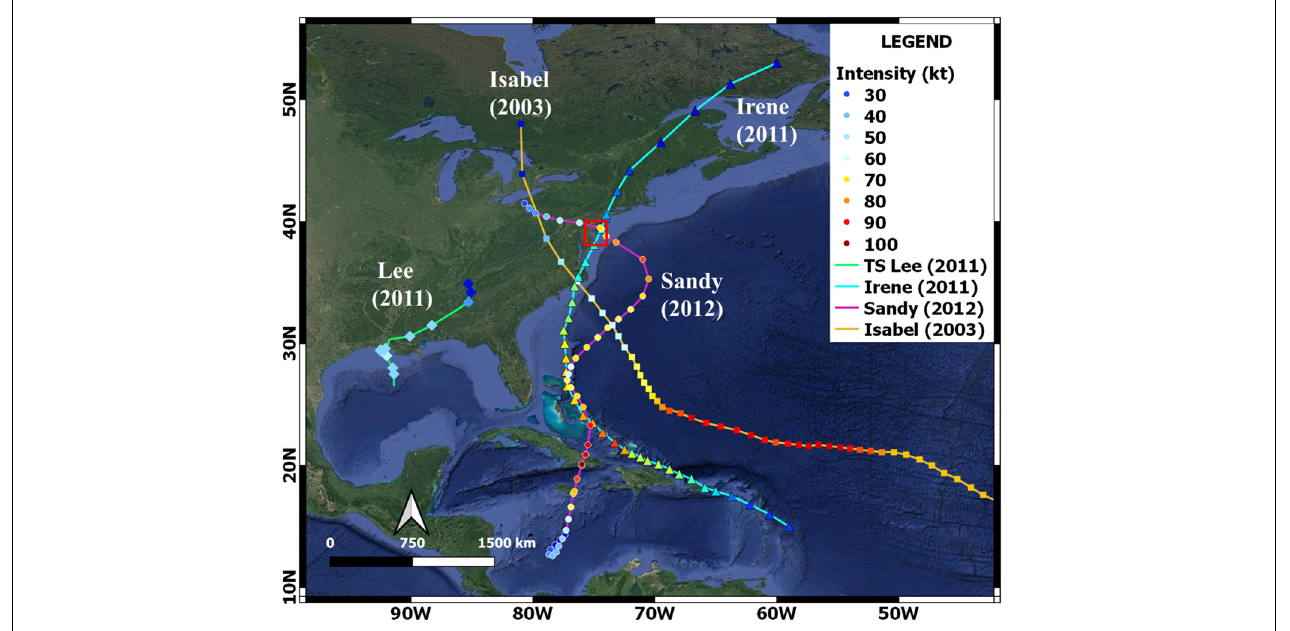
FIGURE 5 | Tracks of selected hurricane and tropical storm events – Isabel (2003), Irene and Lee (2011), and Sandy (2012). Red box indicates the